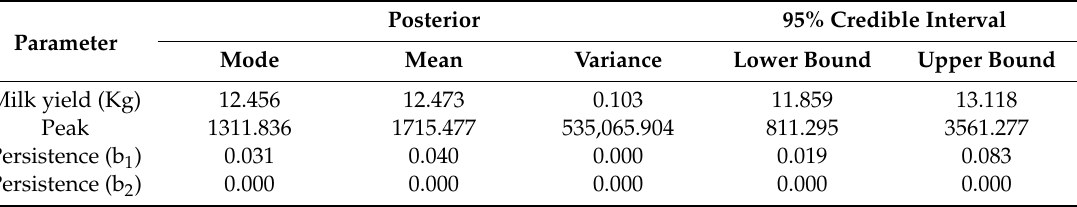
Table 5. Bayesian Posterior distribution estimates for milk yield (Kg), peak and persistence calculated for Ali and Schae ff er model (ALISCH) model in Murciano-Granadina